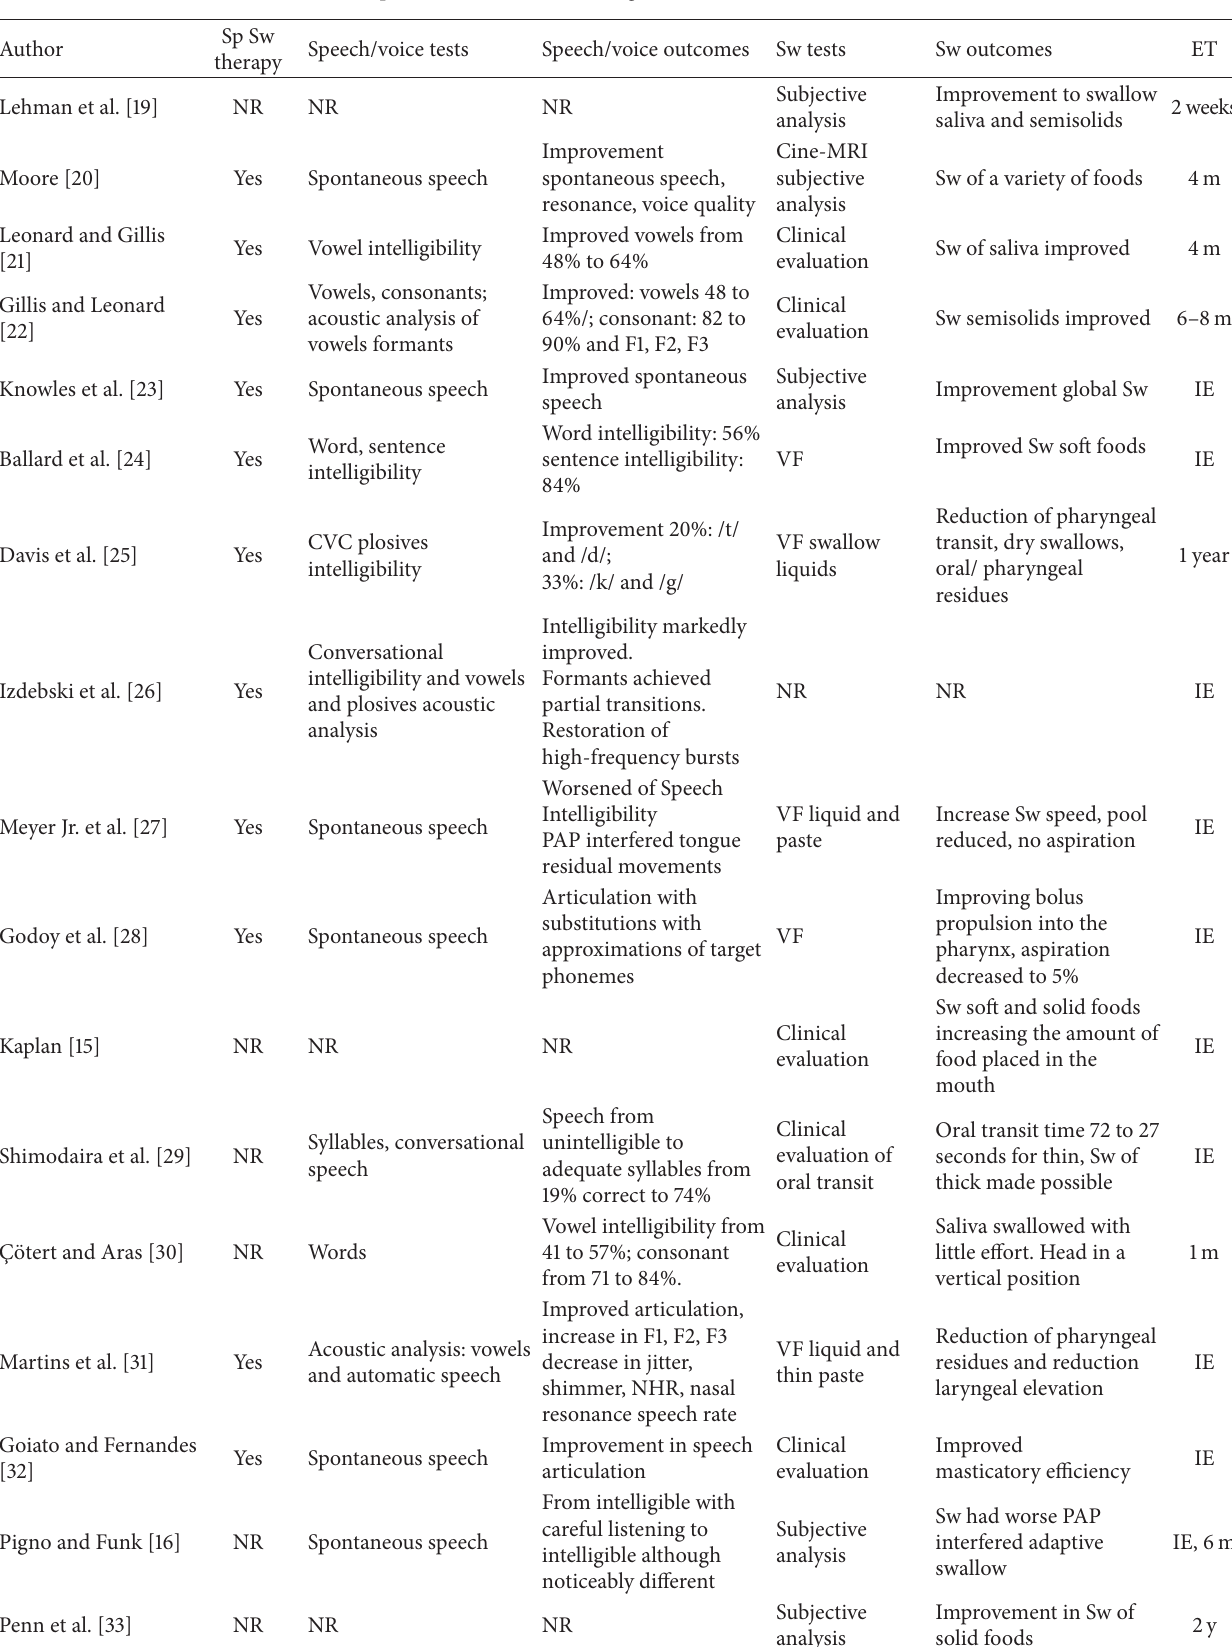
Table 2: Speech, voice, and swallowing outcomes of the included